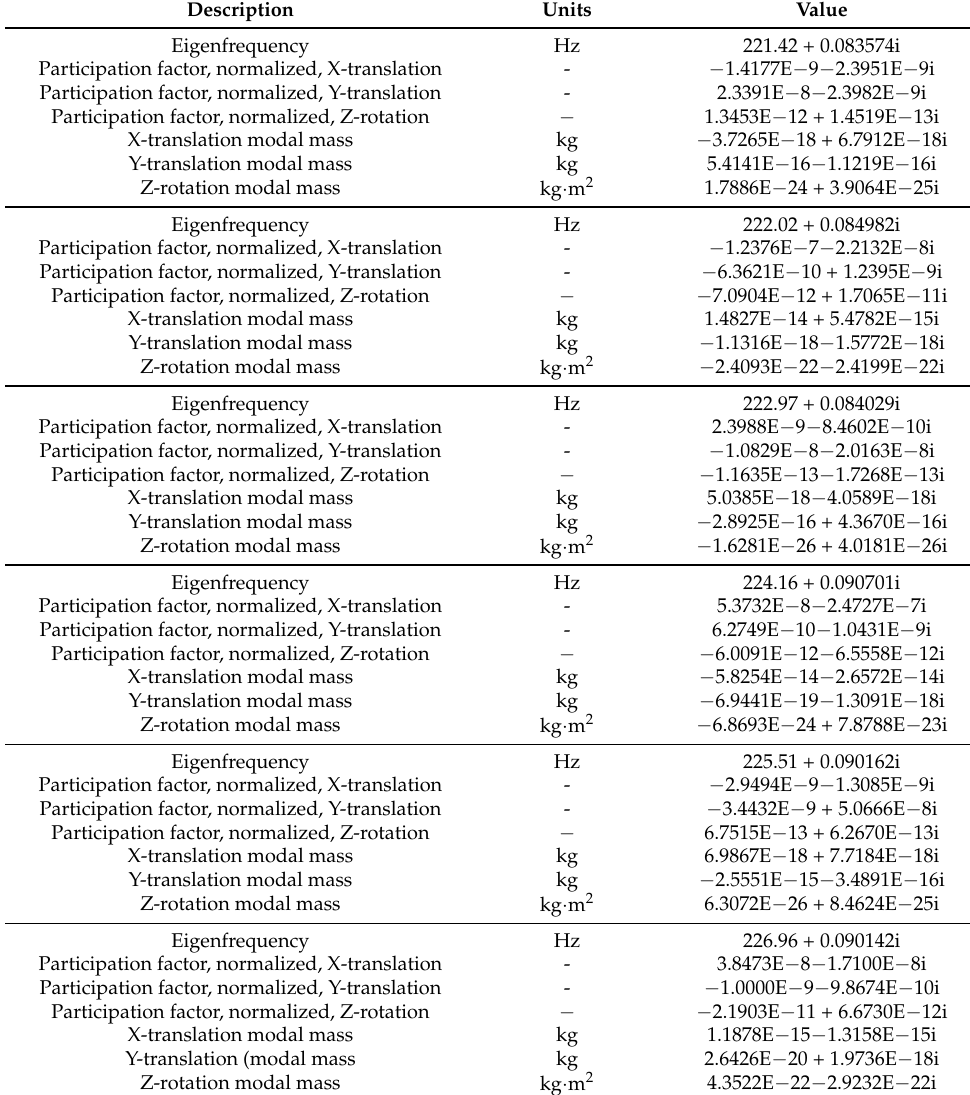
Table 11. Eigenfrequency study of six modes of BAW